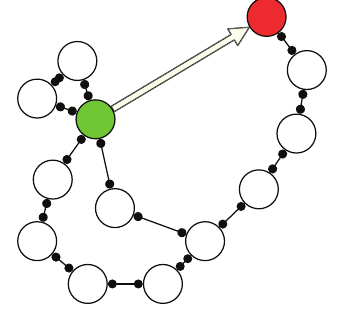
Figure 1: Routing in MANETs.